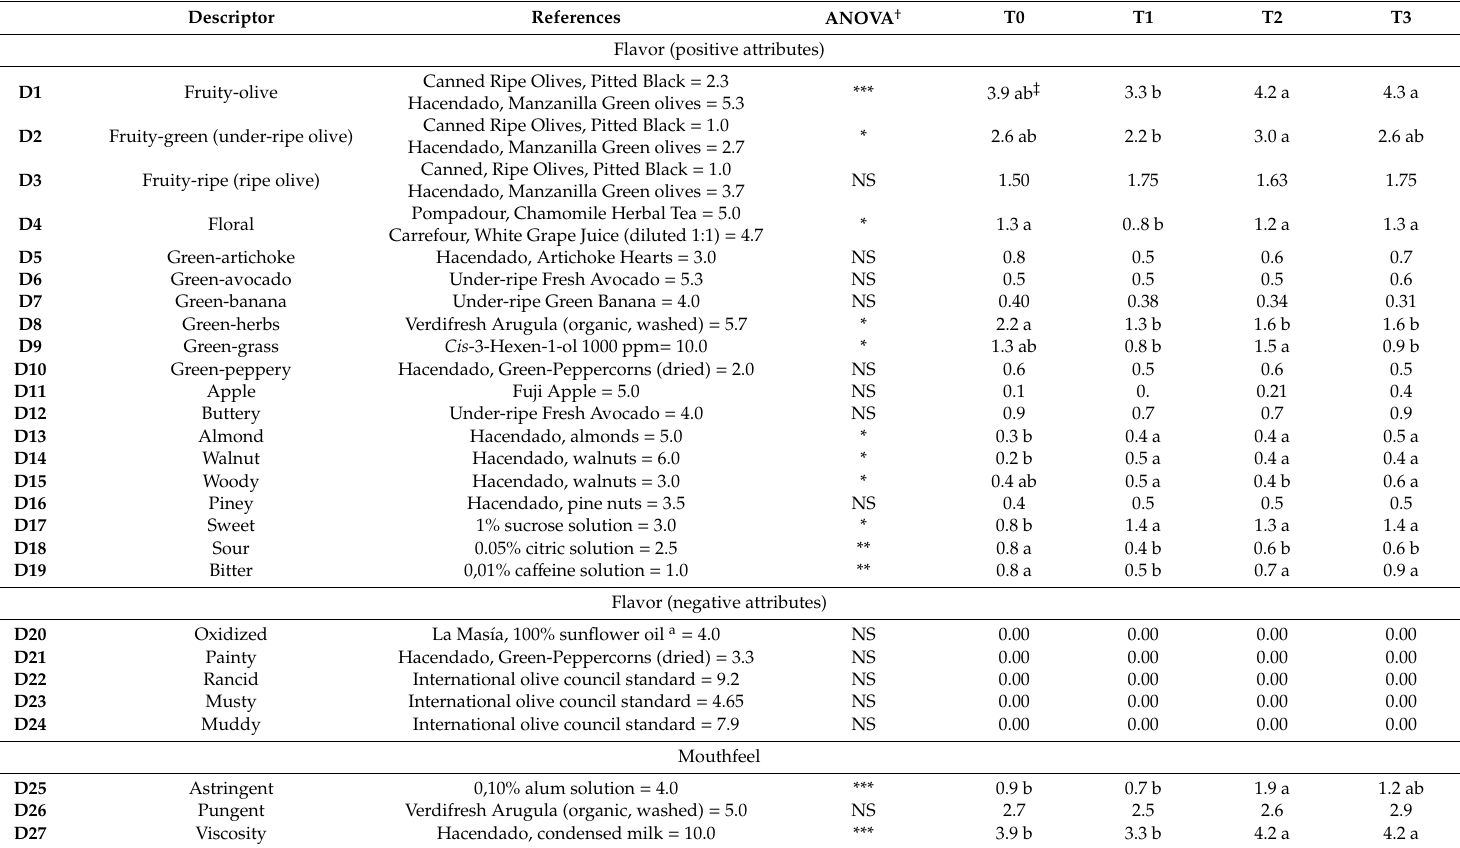
Table 4. Descriptive sensory profiles of “Arbequina” olive oil as a ff ected by the irrigation